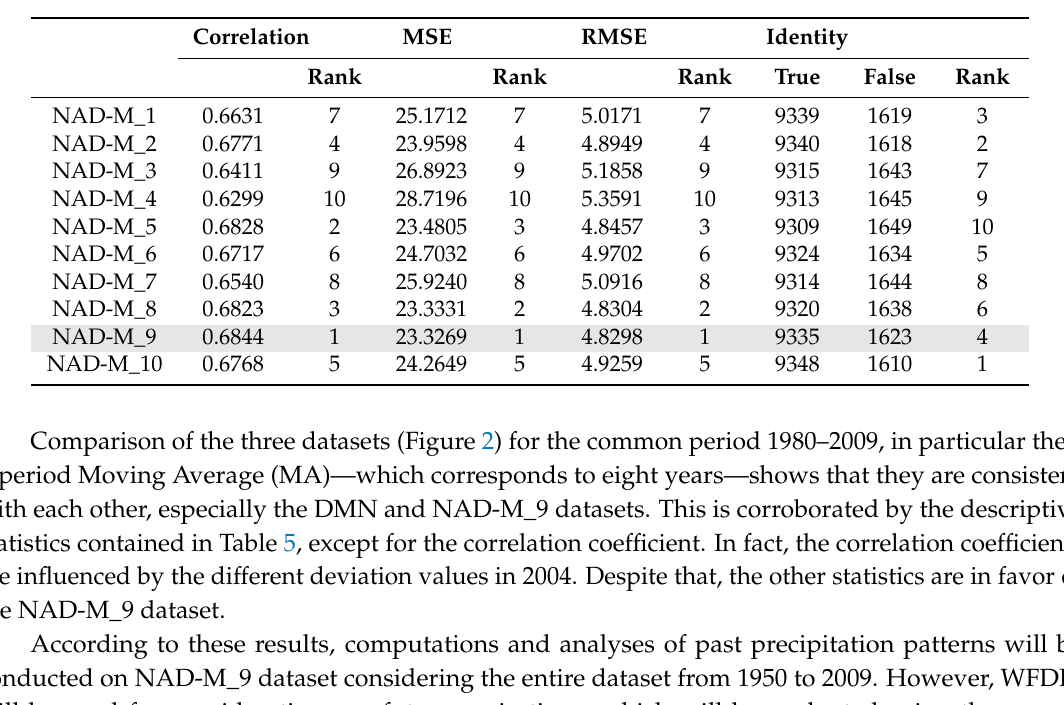
Table 4. Diagnostic verification for precipitation data for each NAD-M ensemble: correlation, MSE, RMSE and identity. The best ranked ensemble is highlighted in grey.